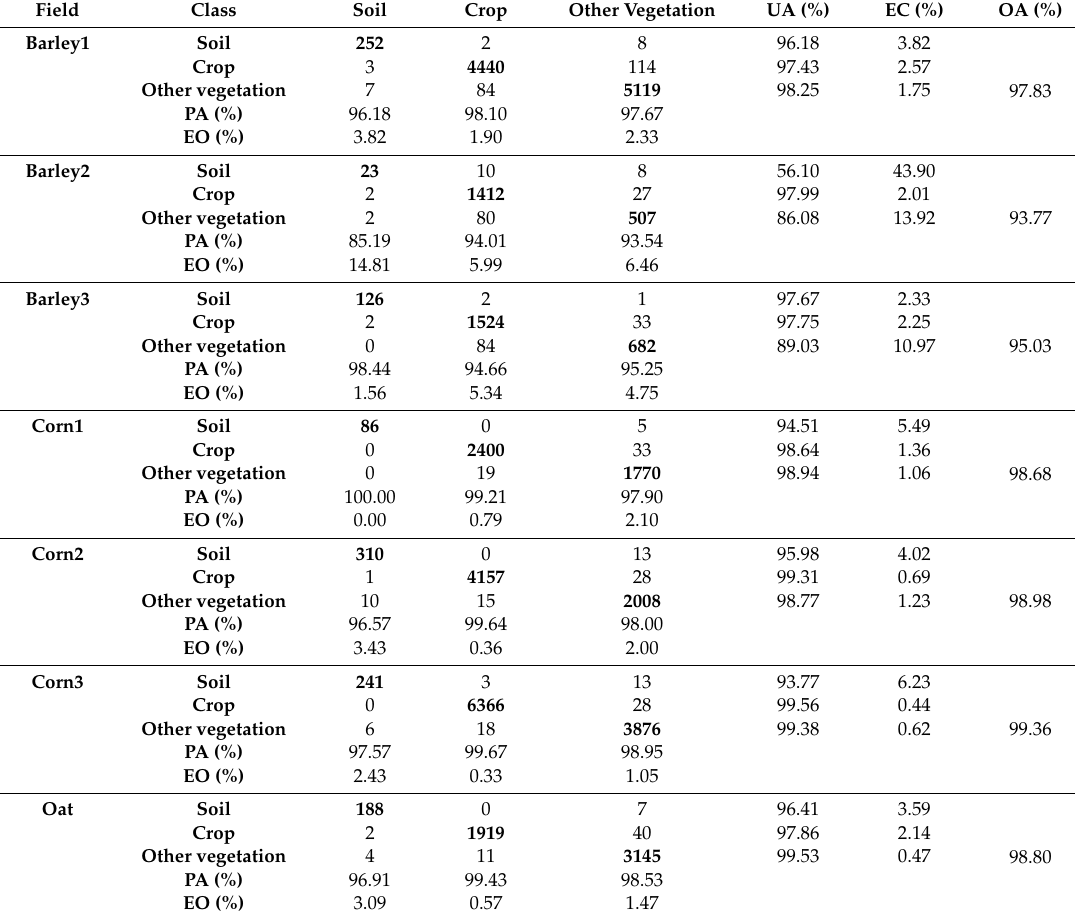
Table 11. Confusion matrices and associated class user’s accuracies, producer’s accuracies, overall accuracies, errors of omission and errors of commission obtained by applying the GEOBIA random forest classifier to the blue, green, red, red-edge, near-infrared reflectance and blue-red simple ratio images. The bold diagonal number elements are the correctly classified objects for each